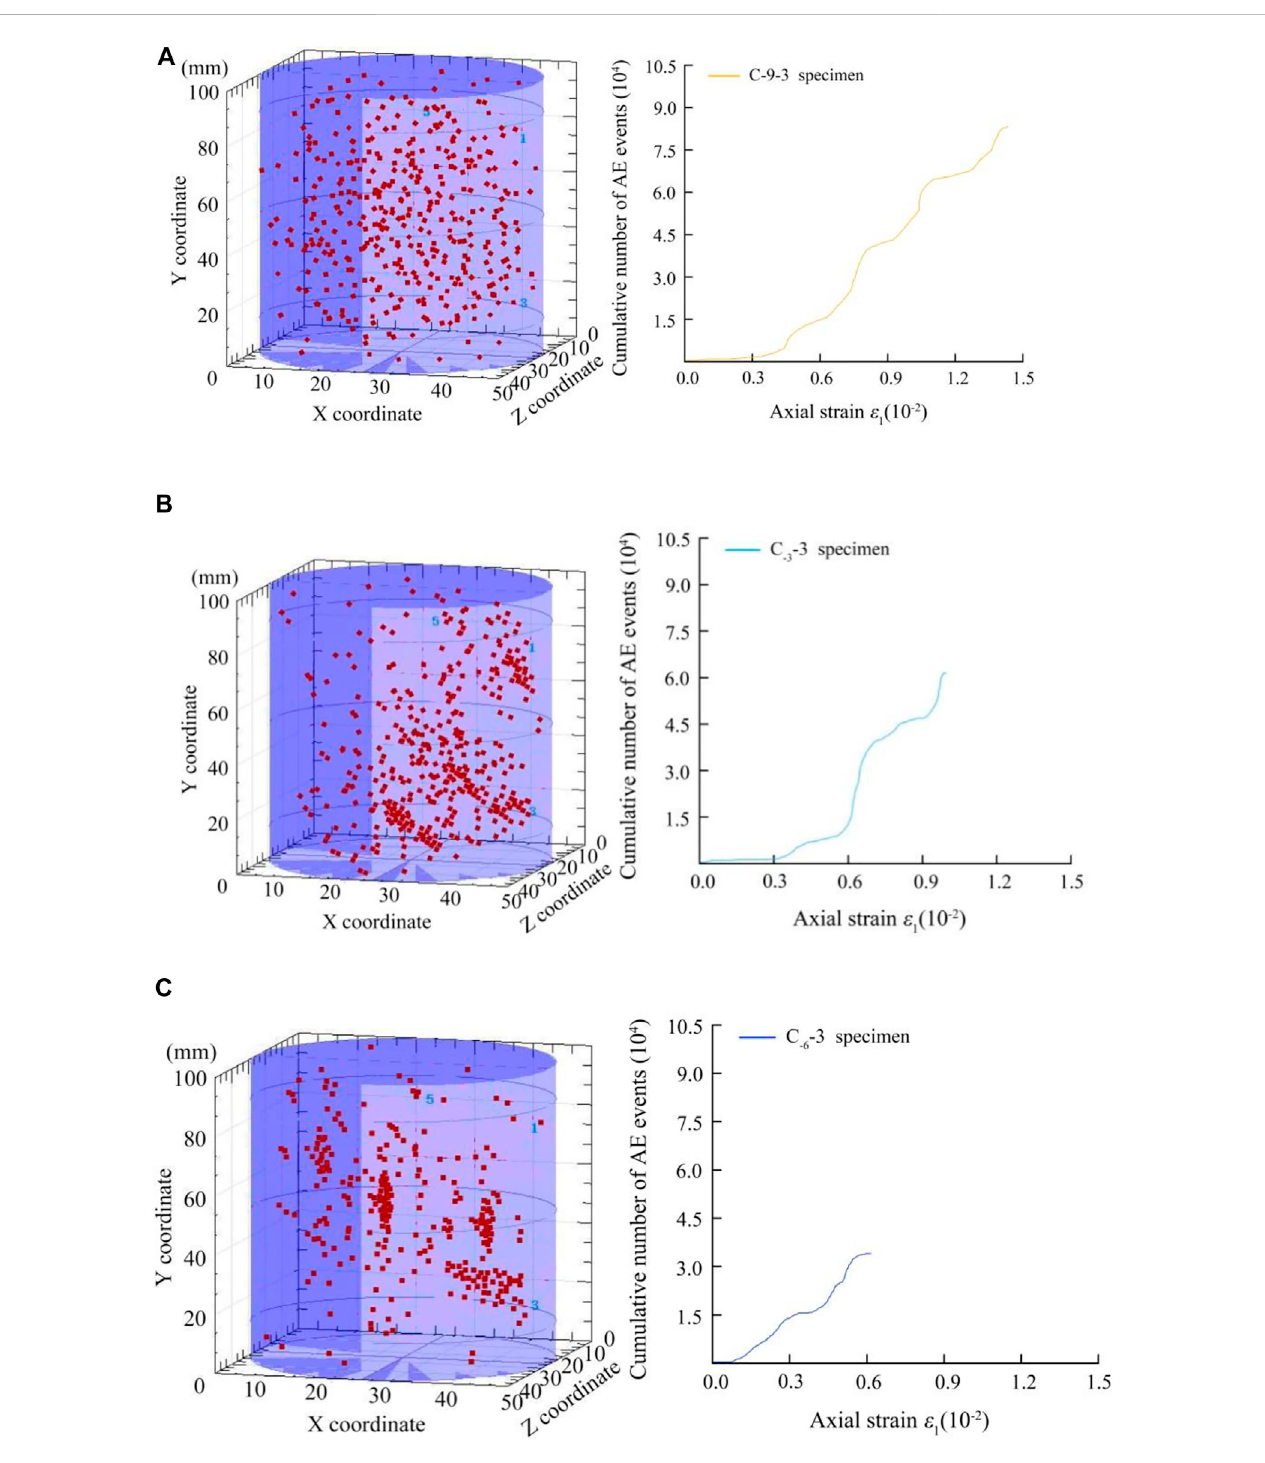
FIGURE 9 Acoustic emission characteristics of coal specimens under different unloading